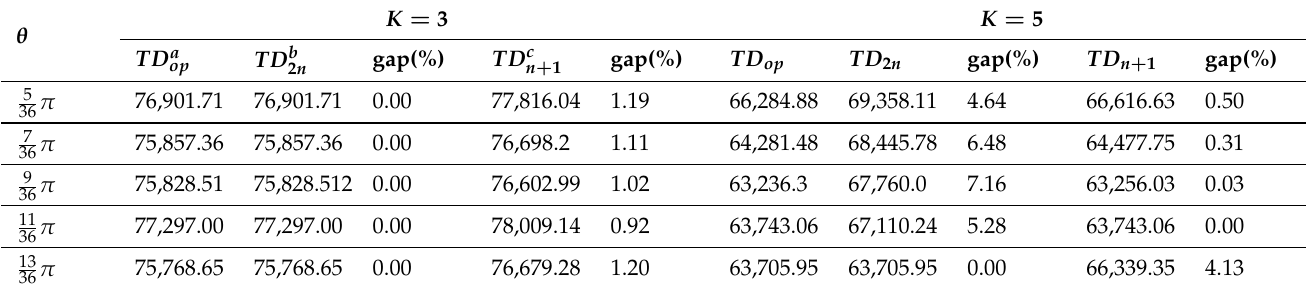
Table 9. Evaluation of two rules for a flying-V layout with varying angles and odd workstation numbers.